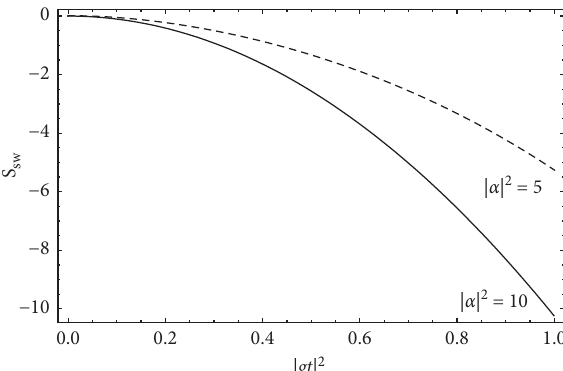
2 in the SW with | gt |